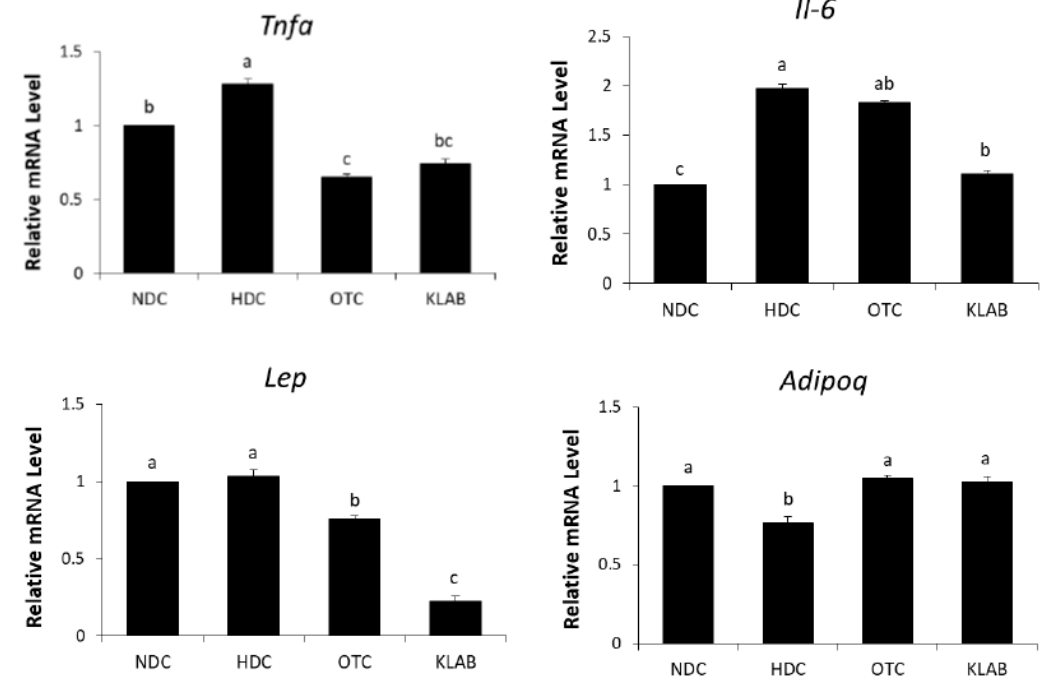
Figure 7. E ff ect of L. brevis OPK-3 on mRNA levels of inflammation cytokine genes in the white adipose tissue of C57BL / 6N mice. Results are Mean ± S.D of 10 mice per group. a-b-c; Values with di ff erent superscripts are significantly di ff erent by ANOVA with Duncan’s multiple range test at p < 0.05. NDC: Normal diet control; HDC: High fat diet control; OTC: high-fat diet plus L-ornithine 20 mg / kg; KLAB: High fat diet plus 1 × 10 9 CFU of L. brevis OPK-3 per mouse. Tnfa : Tumor necrosis factor-alpha; Il-6 : Interleukin 6; Lep : Leptin; Adipoq : Adiponectin.